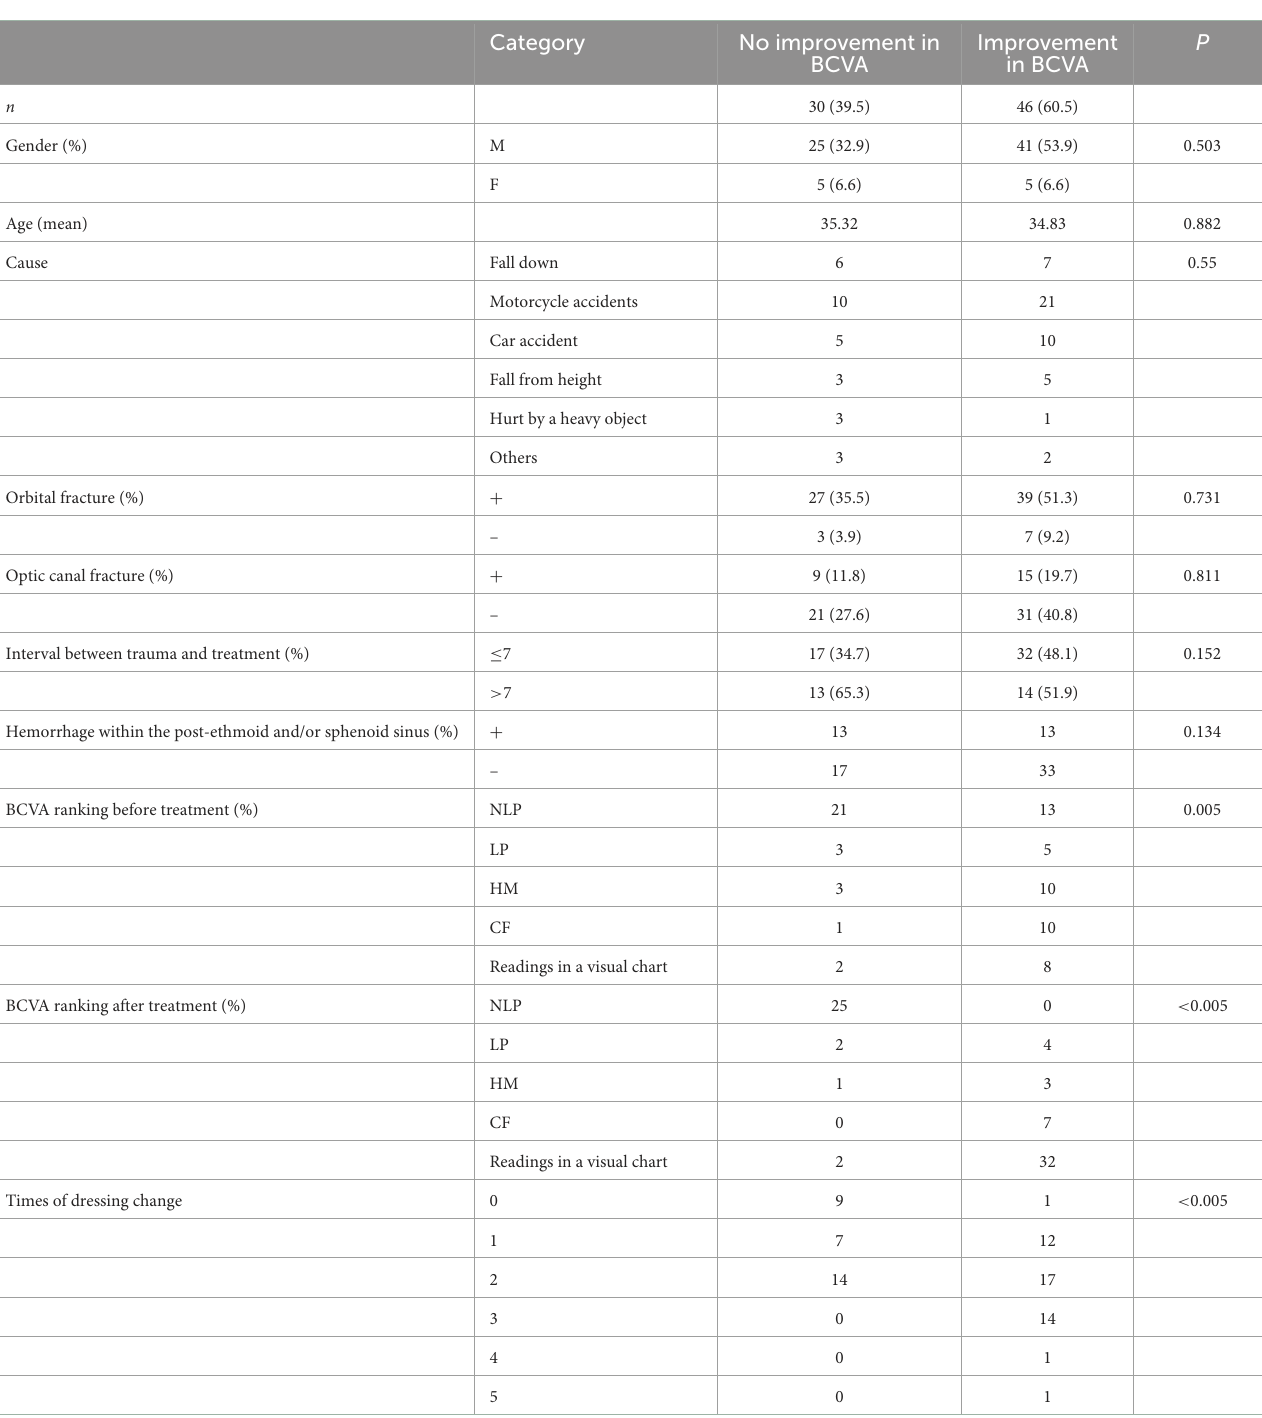
TABLE 1 Clinical features of the